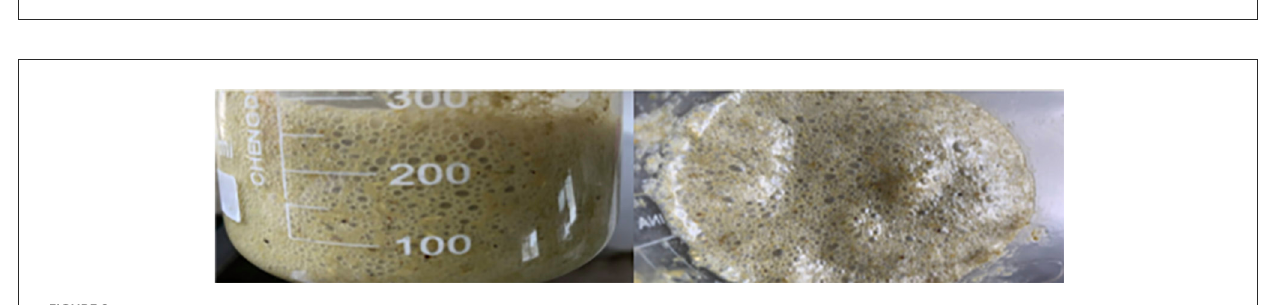
FIGURE2 Rumen bloat in goats with fistulas fed high concentrate diets